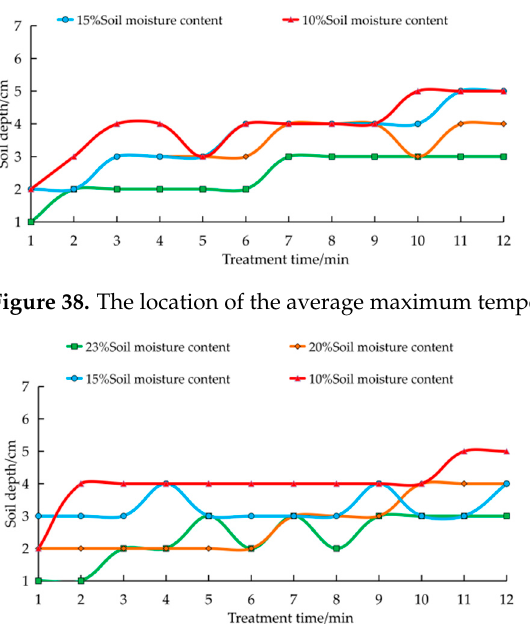
Figure 39. The location of the average maximum temperature ⎯ T n max of the black soil layer.